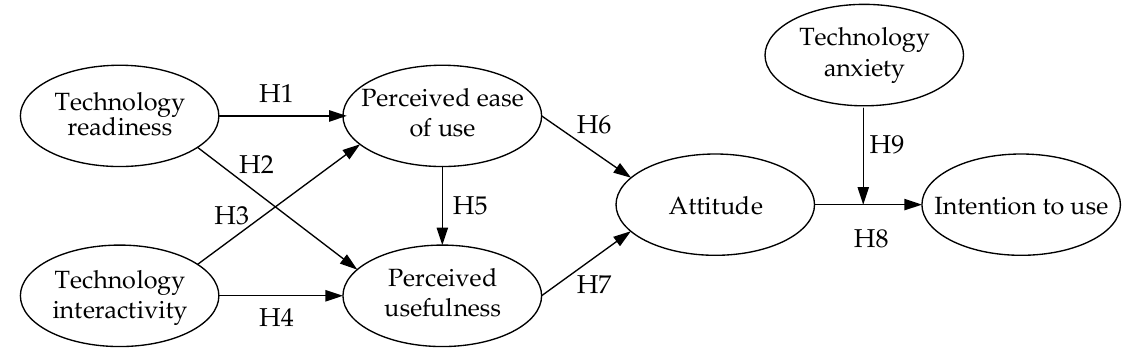
Figure 1. Concept model of the older adults’ behavioral intention to use smart health wearable devices.